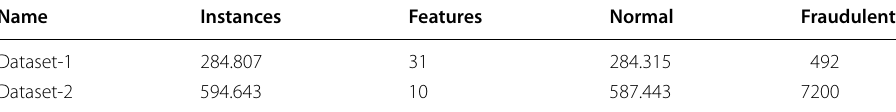
Table 1 The credit card datasets